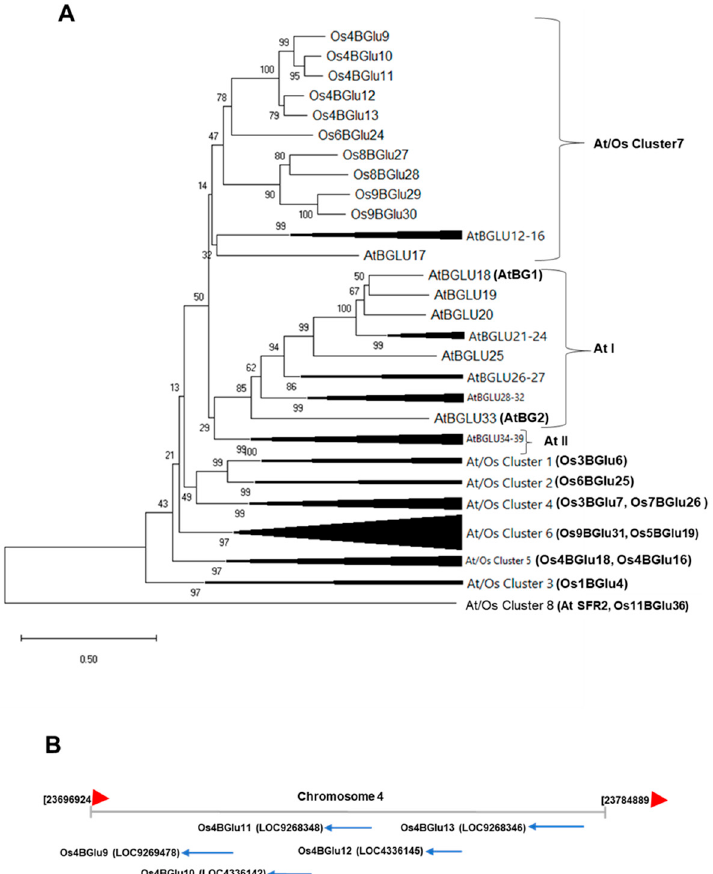
Figure 1. Phylogenetic and genomic relationships between rice family GH1 cluster At/Os7 genes. ( A ) Phylogenetic tree showing the relationship of the predicted protein sequences of rice and Arabidopsis GH1 genes falling in At/Os7 and previously characterized Arabidopsis ABA-GE β -glucosidases (AtBG1 and AtBG2) and other At/Os phylogenetic clusters and two Arabidopsis specific clusters (At I and At II). Characterized rice proteins in other clusters, including those assayed for ABA-GE hydrolysis, and Arabidopsis SENSITIVE TO FREEZING2 (SFR2) and rice galactolipid transgalactosidase are labeled on unexpanded clusters. ( B ) Genomic map of the section on chromosome 4 containing Os4BGlu9-13.